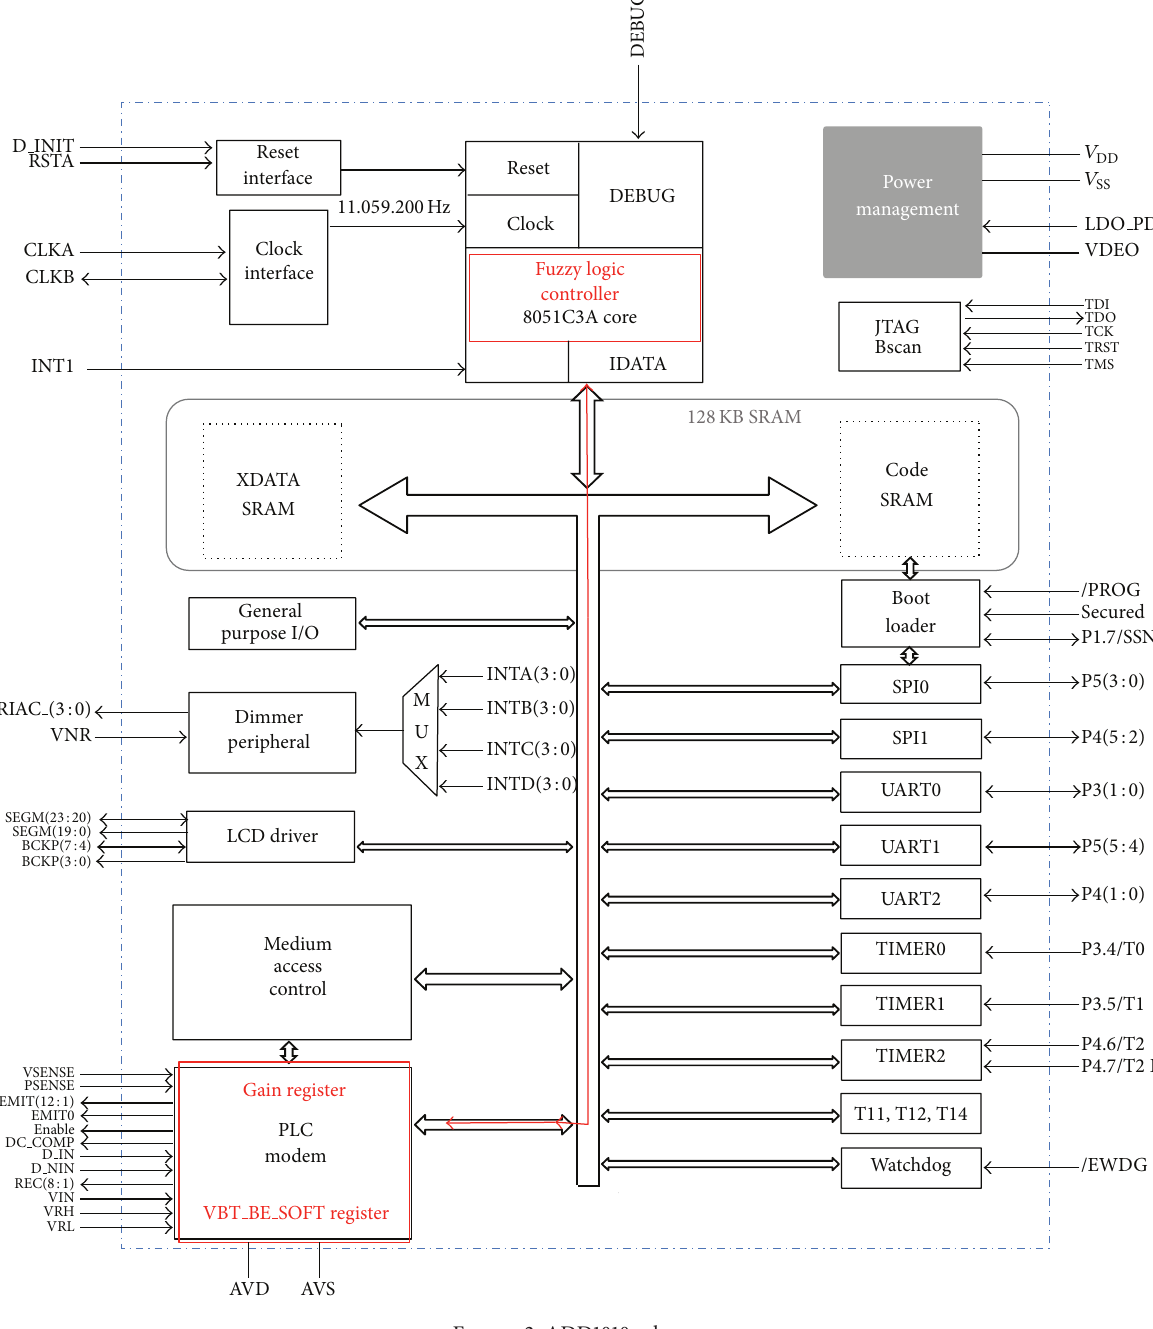
Figure 2: ADD1010